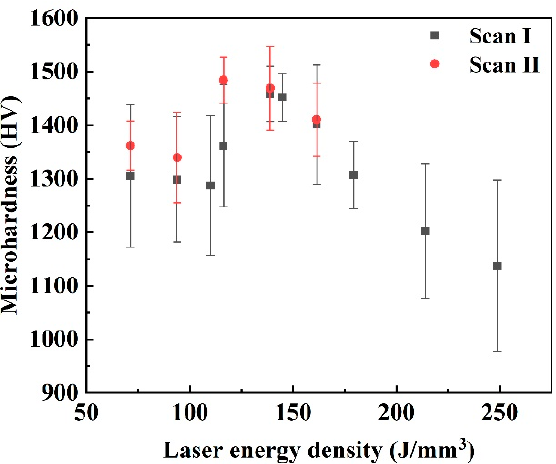
Figure 14. The microhardness of the cemented carbide blocks formed under different laser energy densities.